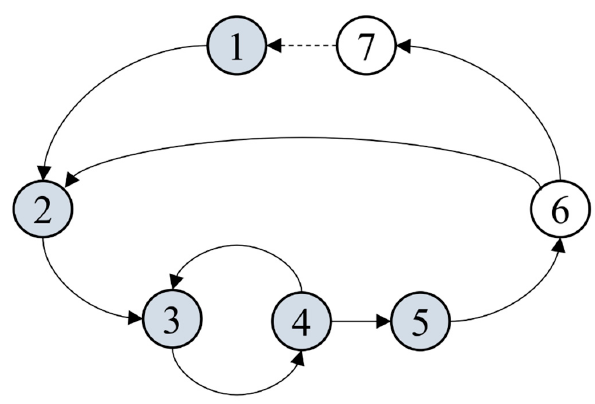
Figure 6. Sequence control with combination of robot jobs and pipetting commands (grey): ( 1 ) Pick–up pipette and pipette initialization, ( 2 ) load tip and move piston to home position, ( 3 ) move to source labware and liquid aspiration and/or liquid dispensing, ( 4 ) move to destination labware and liquid aspiration and/or liquid dispensing, ( 5 ) positioning for tip ejection and eject tip, ( 6 ) positioning for safe starting position, and ( 7 ) place pipette.